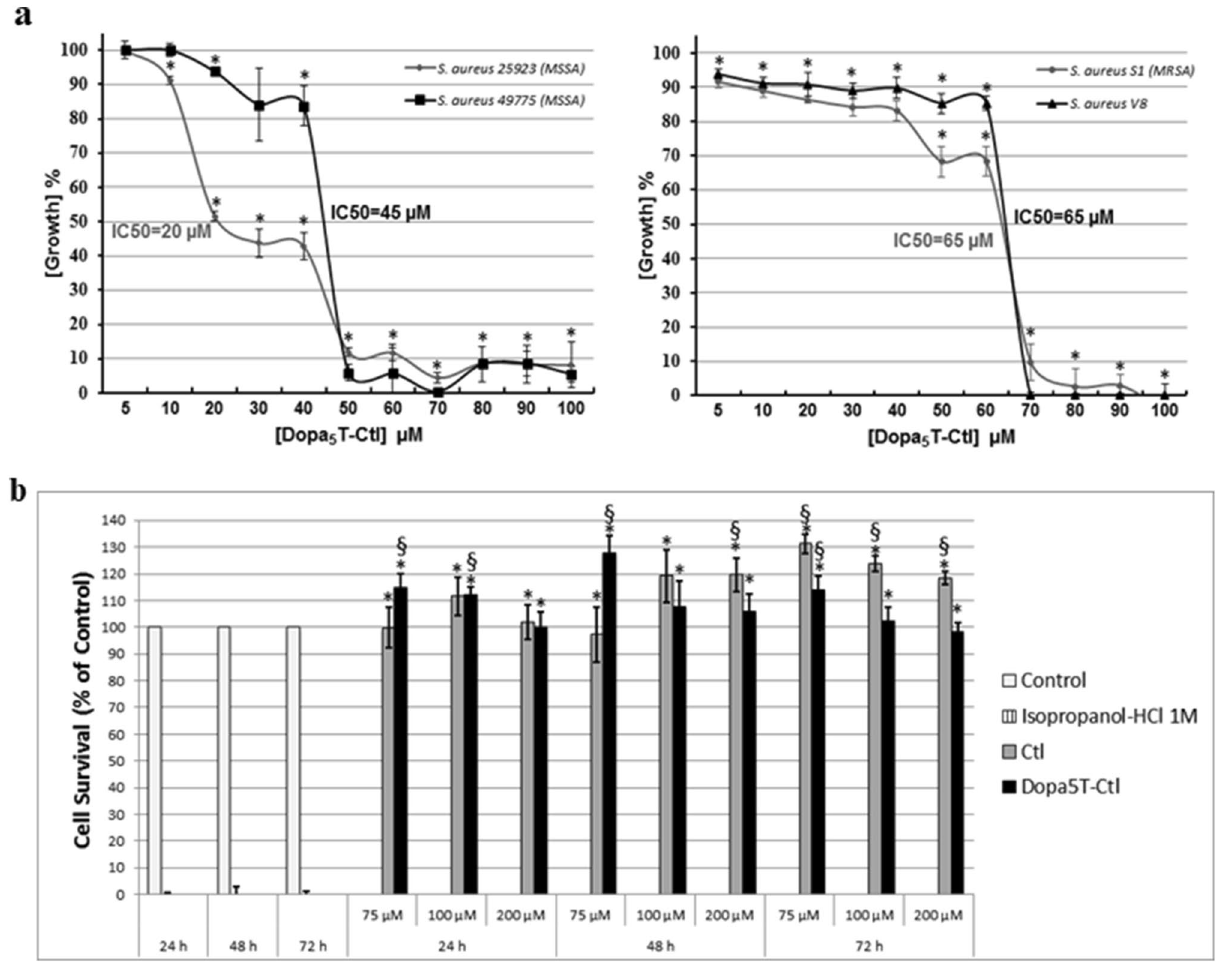
Figure 5. ( a ) Antimicrobial activity of Dopa 5 T-Ctl against different strains of S. aureus ; t-test *p < 0.05 for comparison with the positive control, a mixture of Tetracycline (10 mg/L) and Cefotaxime (0.1 mg/L). Data are shown as mean + /−standard deviation of three independent experiments; ( b ) Toxicity assay against H9c2 cells. t-test §p < 0.05 for comparison with the positive control ( 100% of viability, vehicle ) and *p < 0.05 for comparison with negative control (isopropanol-HCl 1 M). Data are shown as mean + /-standard deviation of three independent